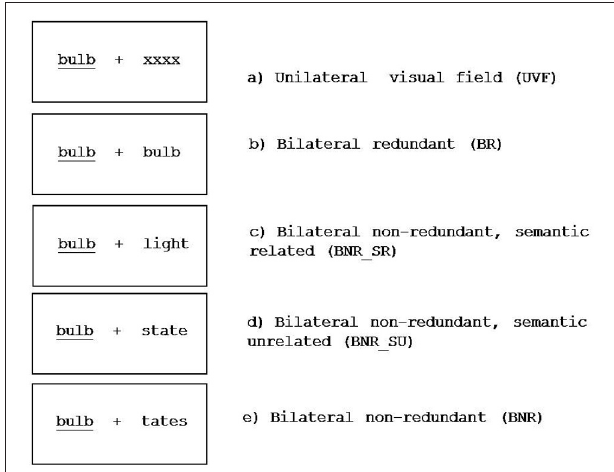
( Figure 1c ): the target and the distractor were SR